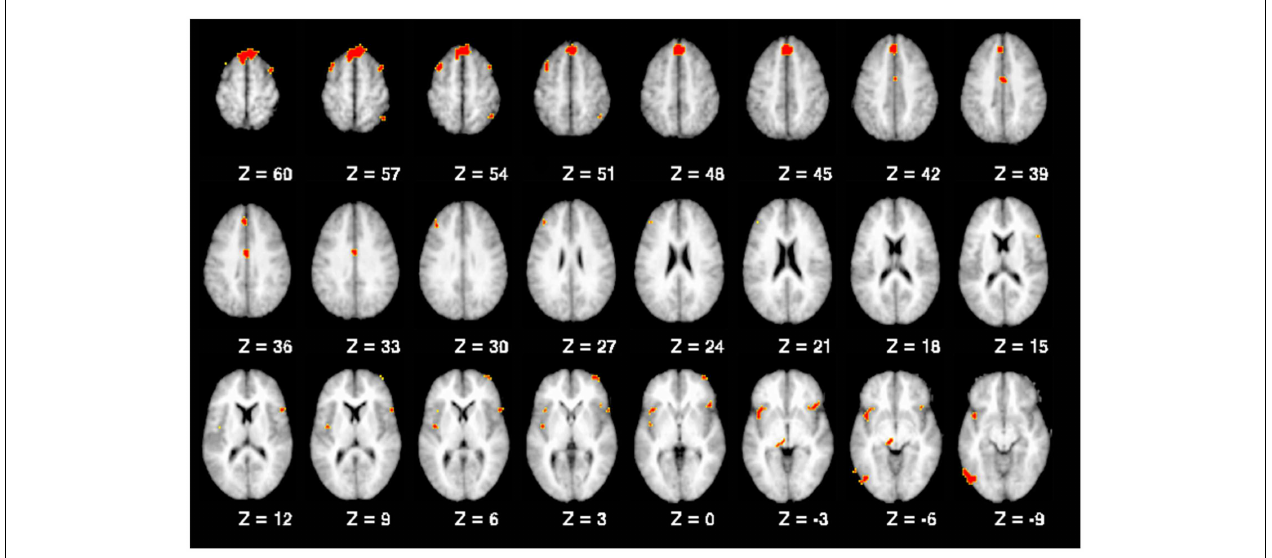
FIGURE 1 |Working memory-related brain regions demonstrating a significant interaction between diagnostic group and past substance abuse . Note: all regions replicated across both n -back tasks, as described in the text. Brain slices are shown with the right hemisphere on the right